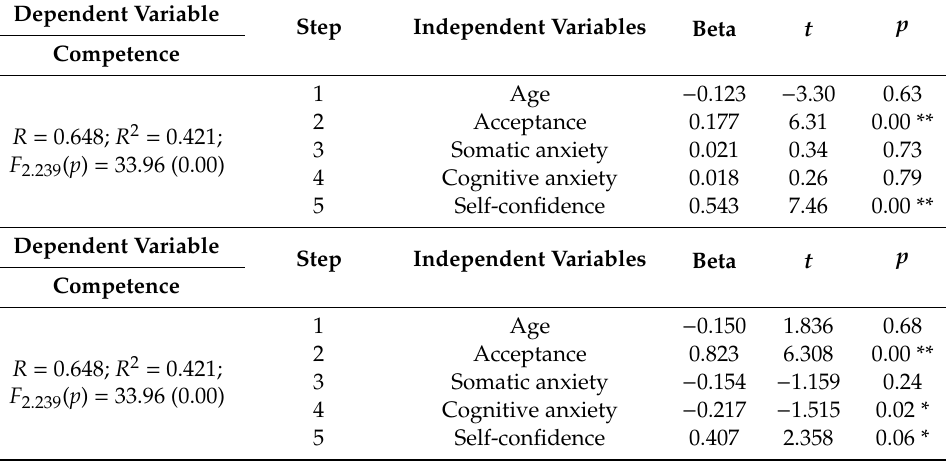
Table 7. Predicting variables of resiliency resources in